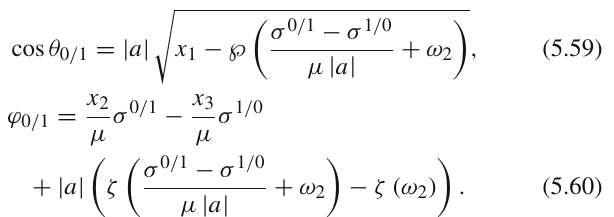
Fig. 4 The moduli space of elliptic string